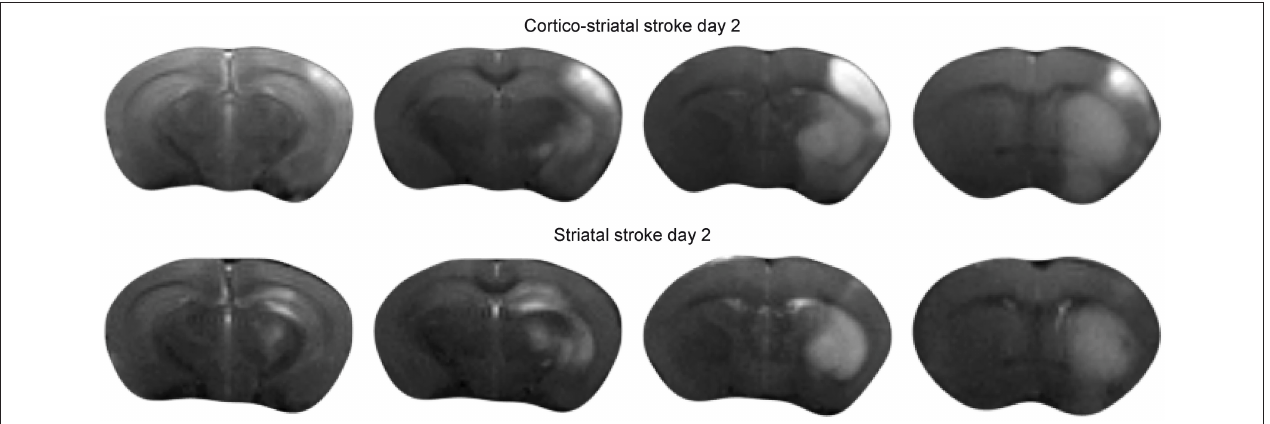
FIGURE 1 | Acute ischemic stroke lesion on T2-weighted MRI. Multislice T2-weighted MR images at 48h after stroke induction, directly before implantation of neural stem cells. The hyperintensity on the MR images clearly demarcates the extent of the ischemia-affected tissue: the upper row shows the spread of the lesion across the cortical and sub-cortical tissue areas of a representative animal with cortico-striatal lesion. The lower row presents the situation for a representative mouse of the striatal lesion group.